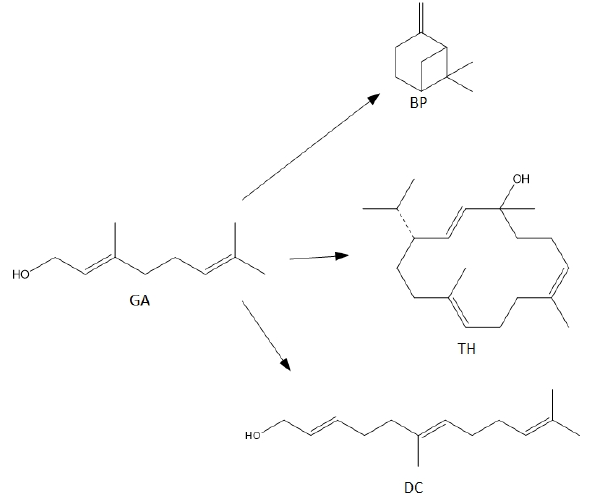
Figure 8. The main reactions describing process of transformations of geraniol in the presence of diatomite.